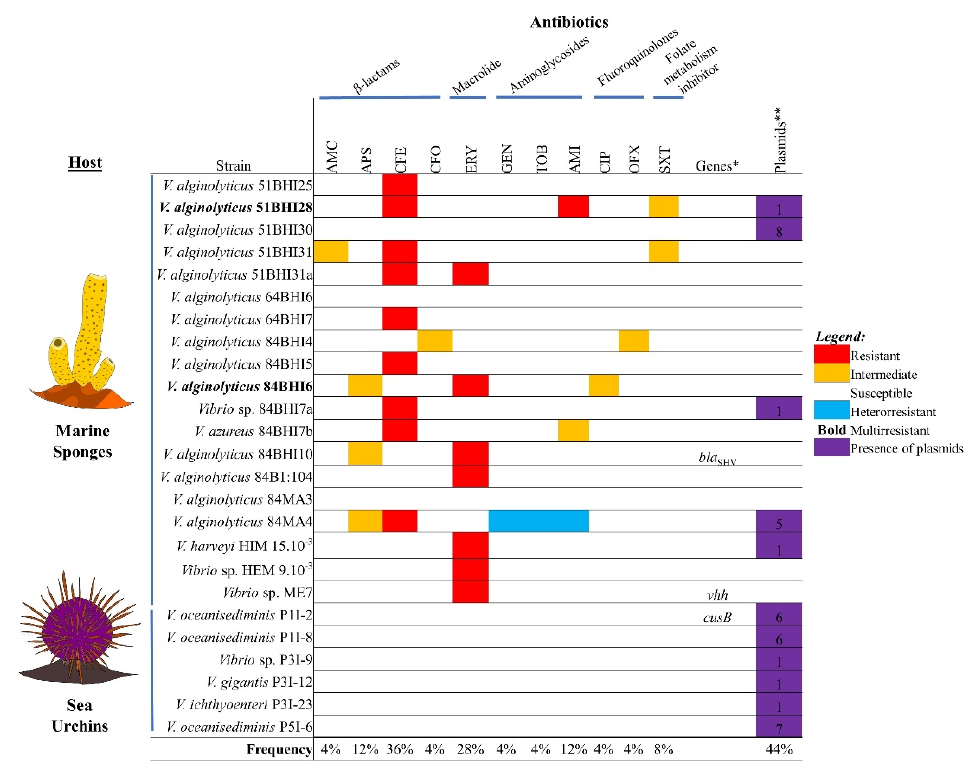
Figure 1. Non-susceptibility frequency of Vibrio spp. strains from marine sponges and sea urchins. The isolates were classified as resistant, multirresistant, intermediate, susceptible or heteroresistant to antibiotics. The antibiotic and heavy metal resistance genes, virulence genes (*) and number of plasmid forms (**) detected were shown. AMC: amoxicillin-clavulanic acid; AMI: amikacin; APS: ampicillin-sulbactam; CFE: cephalexin; CFO: cefoxitin; CIP: ciprofloxacin; ERY: erythromycin; GEN: gentamicin; OFX: ofloxacin; SXT: trimethoprim/sulfamethoxazole; TOB: tobramycin.